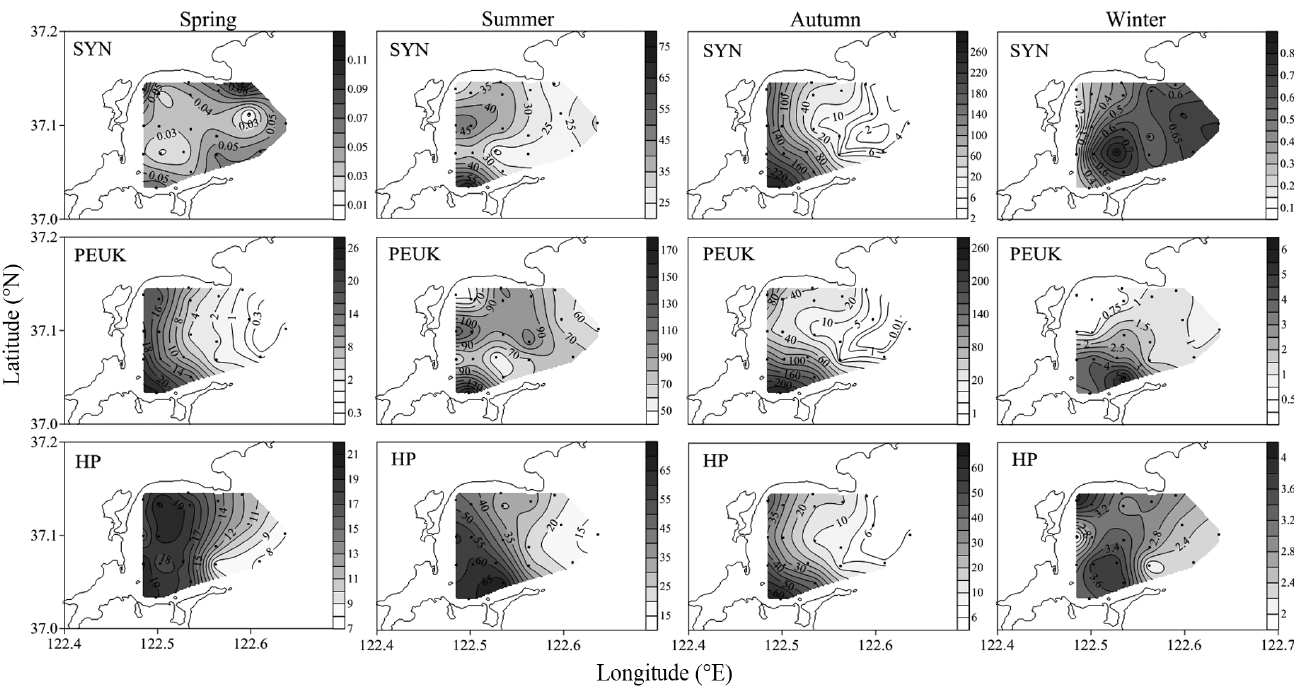
Fig. 3. Spatial distribution of picoplankton abundance in Sanggou Bay and adjacent area over 4 successive seasons. Syne- chococcus (SYN) and picoeukaryotes (PEUK): ×10 3 cells cm −3 ; heterotrophic prokaryotes (HP): ×10 5 cells cm −3